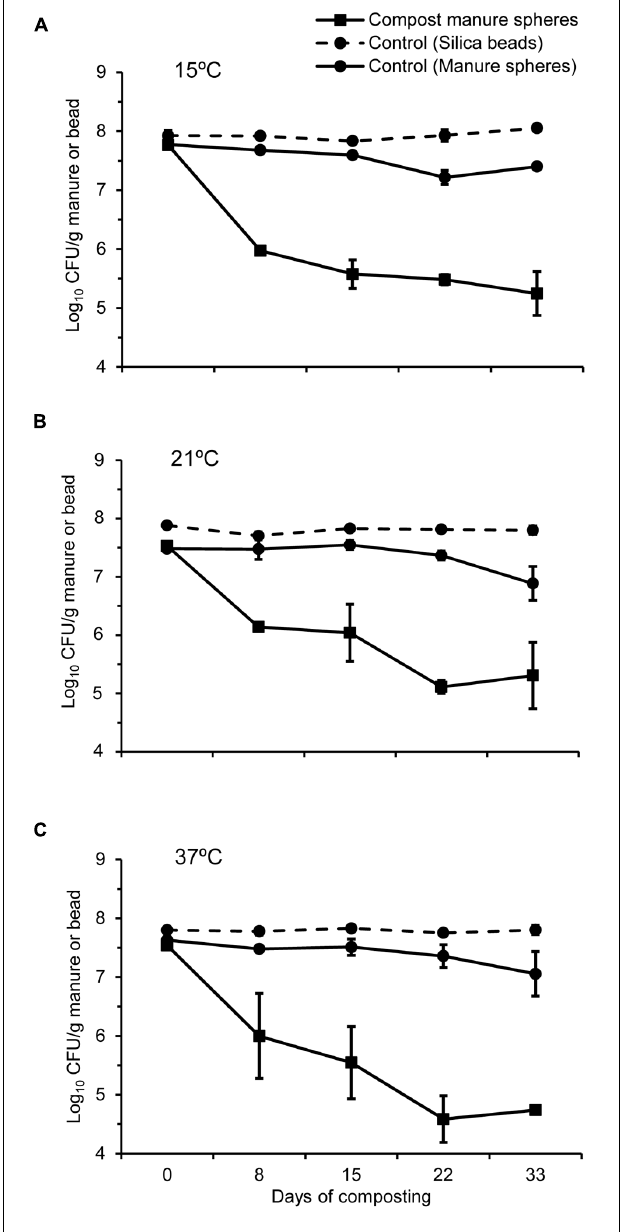
FIGURE 4 | Survival of B. anthracis spores (Log 10 CFU g − 1 manure) generated at different temperatures (A) 15 ◦ C, (B) 21 ◦ C, and (C) 37 ◦ C and placed in manure spheres that were composted with feedlot cattle manure for 33 days. For controls, silica beads and fresh manure spheres were inoculated with B. anthracis spores and kept at room temperature over 33